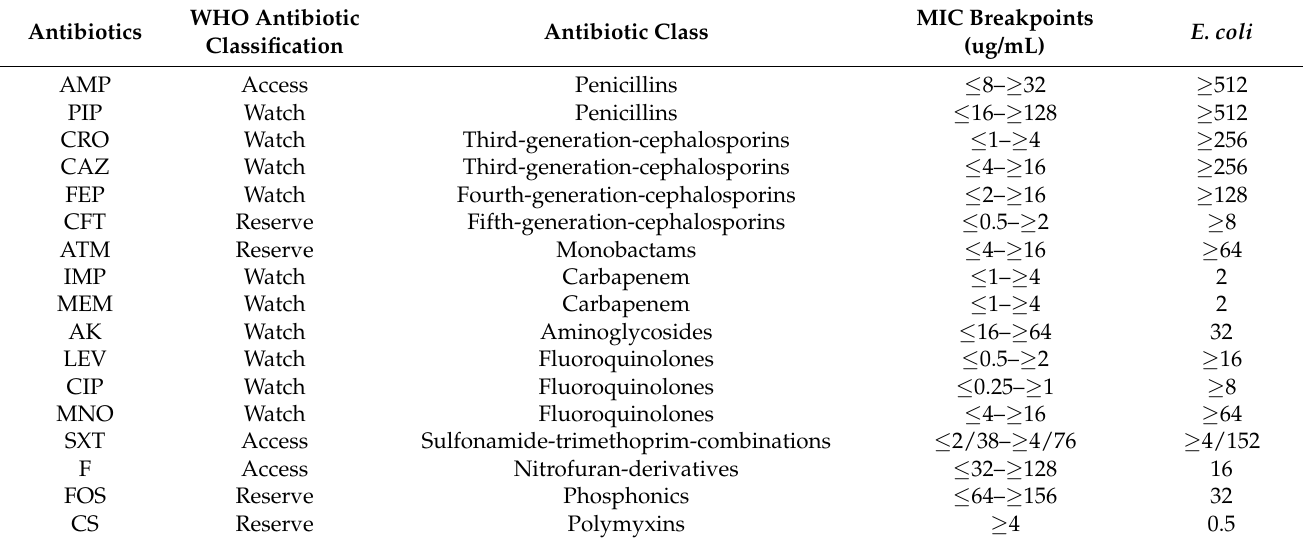
Table 1. MIC ( µ g/mL) of antibiotics against ESBL-producing E. coli ST131.